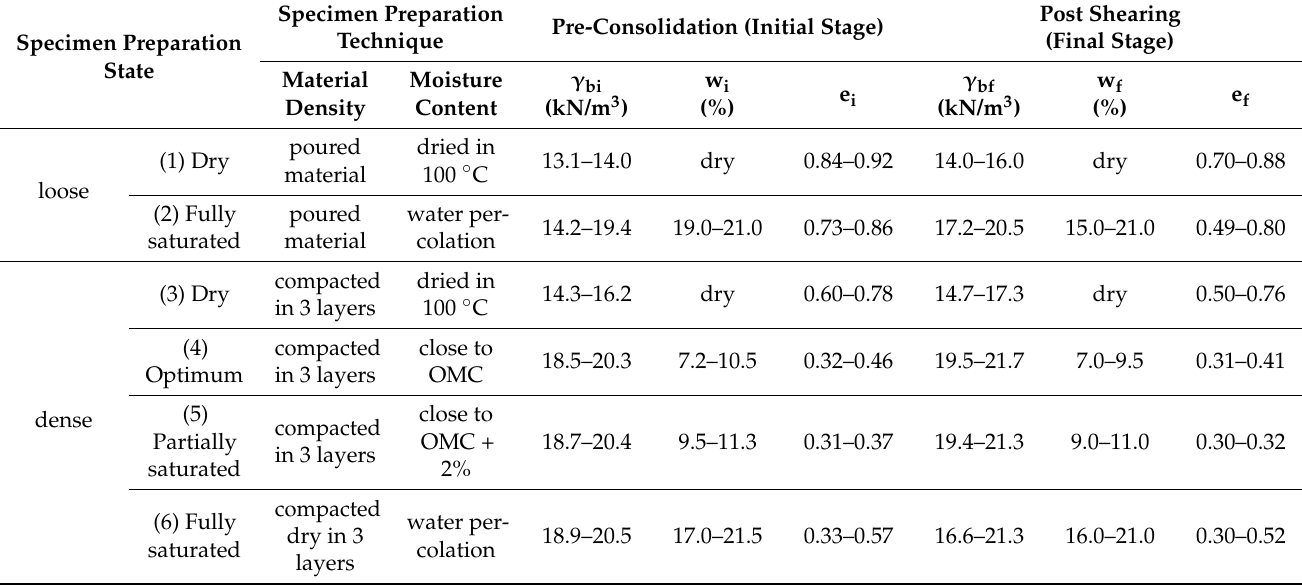
Table 2. Summary of the flysch specimen preparation techniques for the large shear box testing with the unit weight ( γ ), moisture (w), and void ratio (e) specimen properties in the initial and after shearing